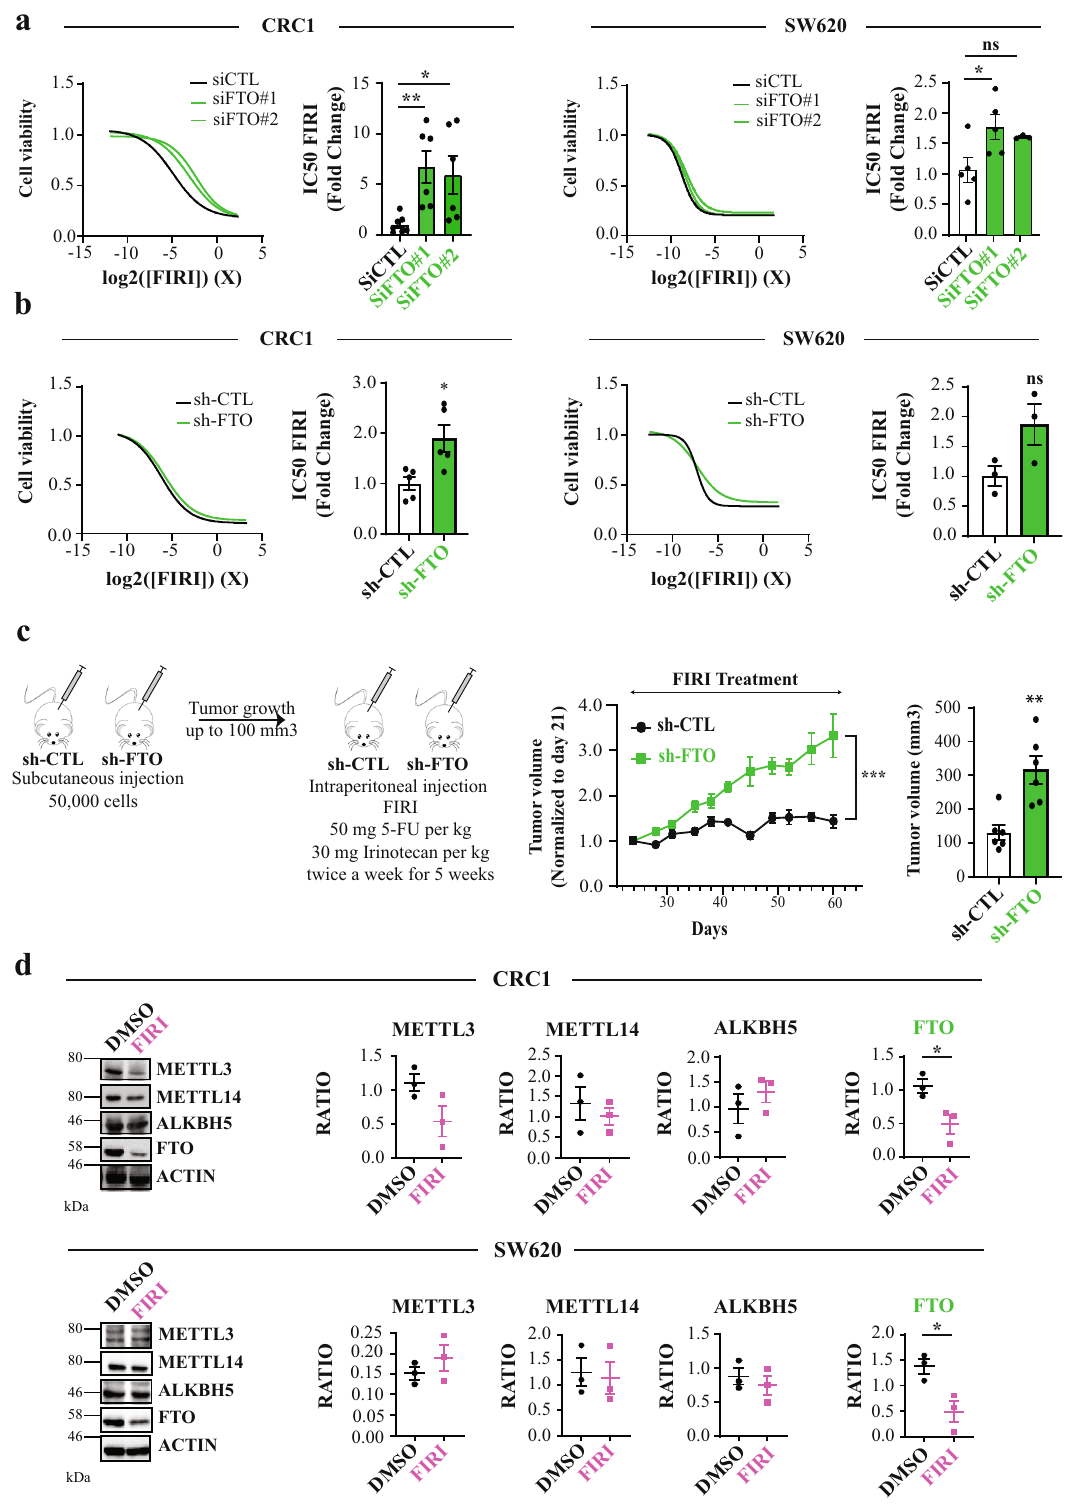
(Fig. 4g). PCIF1 is also expressed at lower level in metastatic cell lines (Fig. S4g, h), concomitantly with reduced FTO expression (Fig. 3a). Balanced decrease of m 6 A m writer and eraser (Fig. S4i) would explain the lack of change of m 6 A m level with respect to cell lines originating from primary tumor (Fig. 4b). Nevertheless, several lines of evidence suggest that FTO- mediated and PCIF1-mediated m 6 A m dynamics cannot be